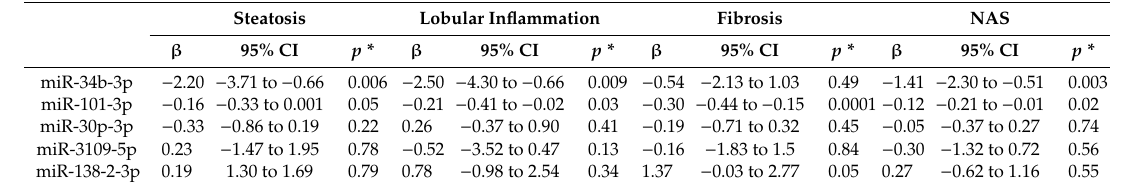
Table 2. Histological variables associated with hepatic miRNA expression at multivariate generalized linear model analysis in wt and InsR +/ − mice fed a standard or MCD